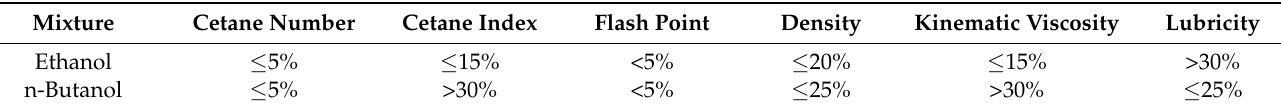
Table 4. Mixtures which comply with EN 590 + A1.